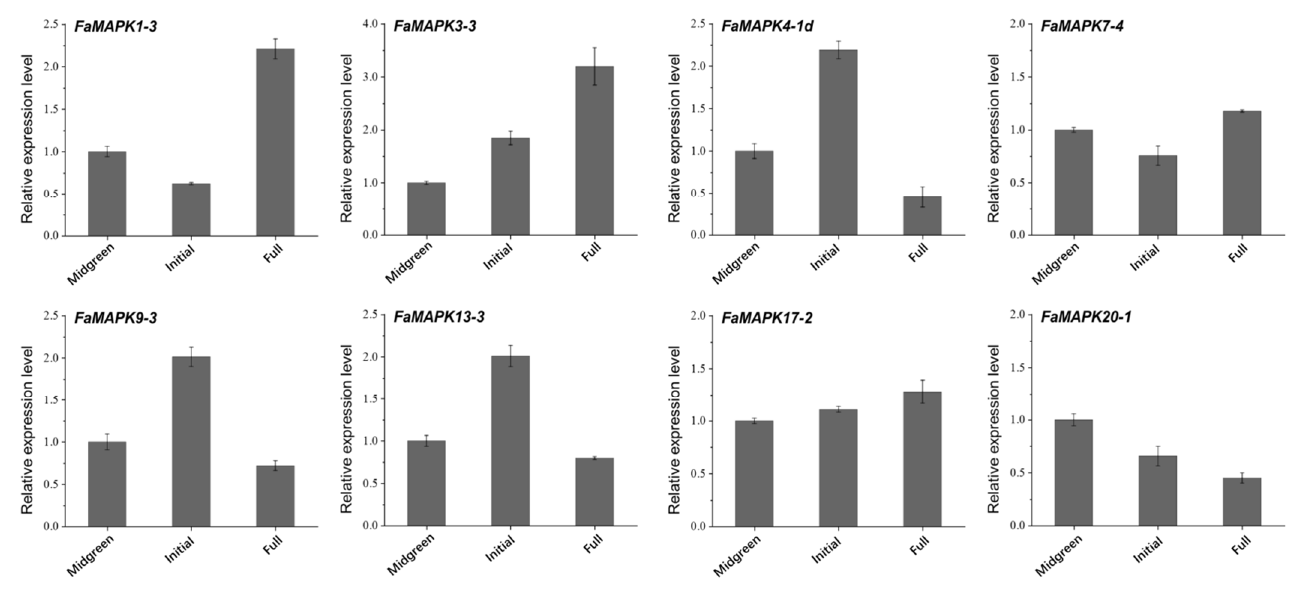
Figure 9. Expression profiles of FaMAPK genes at different fruit developmental stages.